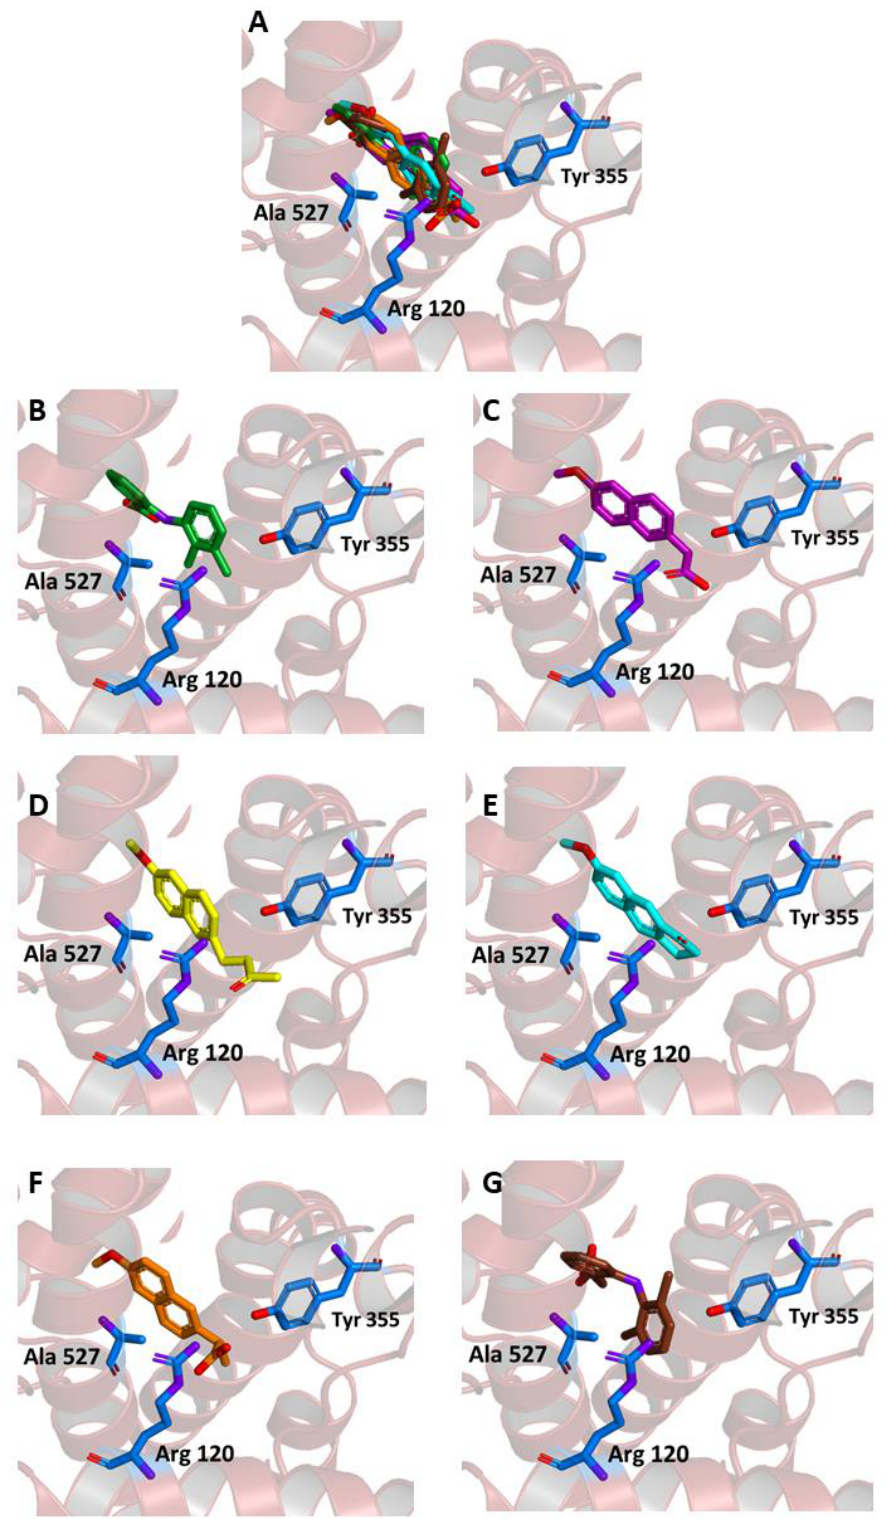
Figure 4. Ligand binding into the active site of COX-2. Protein backbone is represented in the background as a ribbon and only key residues are highlighted. ( A ) Superimposed binding modes of the MEF (green), MNA (purple), NB (yellow), MC (cyan), NAP (orange), and DIC (brown). The ligands are also shown separately: ( B ) MEF, ( C ) MNA, ( D ) NB, ( E ) MC, ( F ) NAP, and ( G ) DIC.